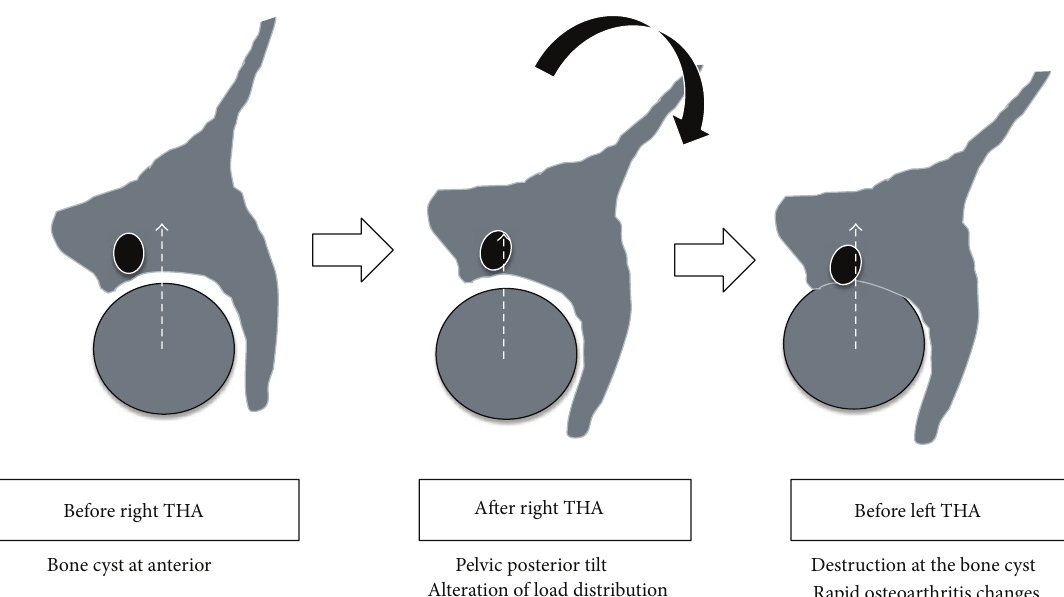
Figure 5: Schema of the estimated mechanism of rapid osteoarthritis changes in our